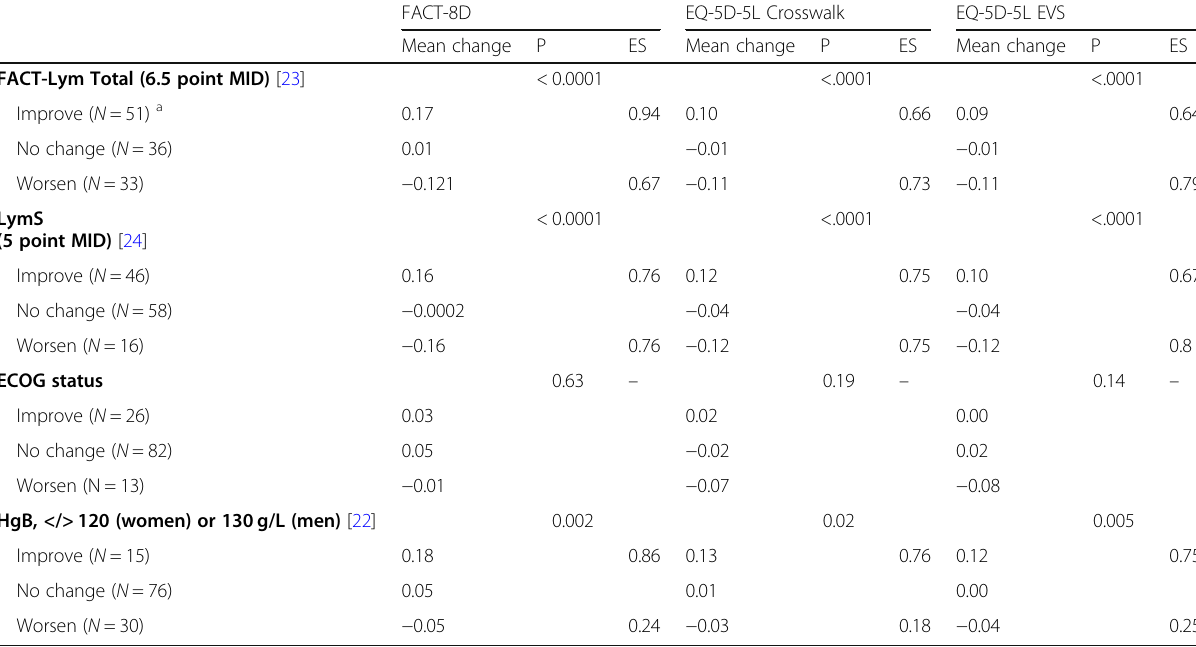
Table 3 Results of responsiveness testing for FACT-8D and EQ-5D-5L using data from baseline to 31